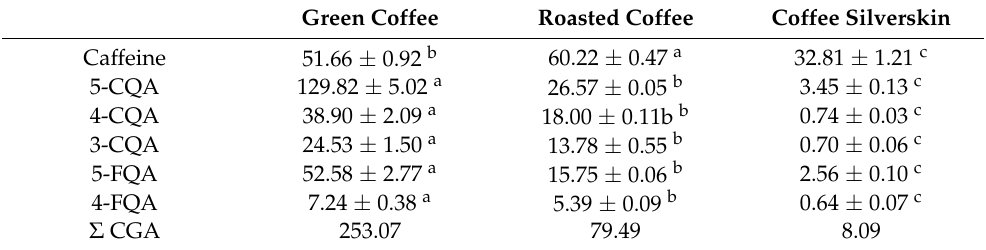
Table 1. Caffeine and CGA contents (mg/g of freeze-dried extract) of green coffee, roasted coffee, and coffee silverskin extracts prepared by ultrasound-assisted